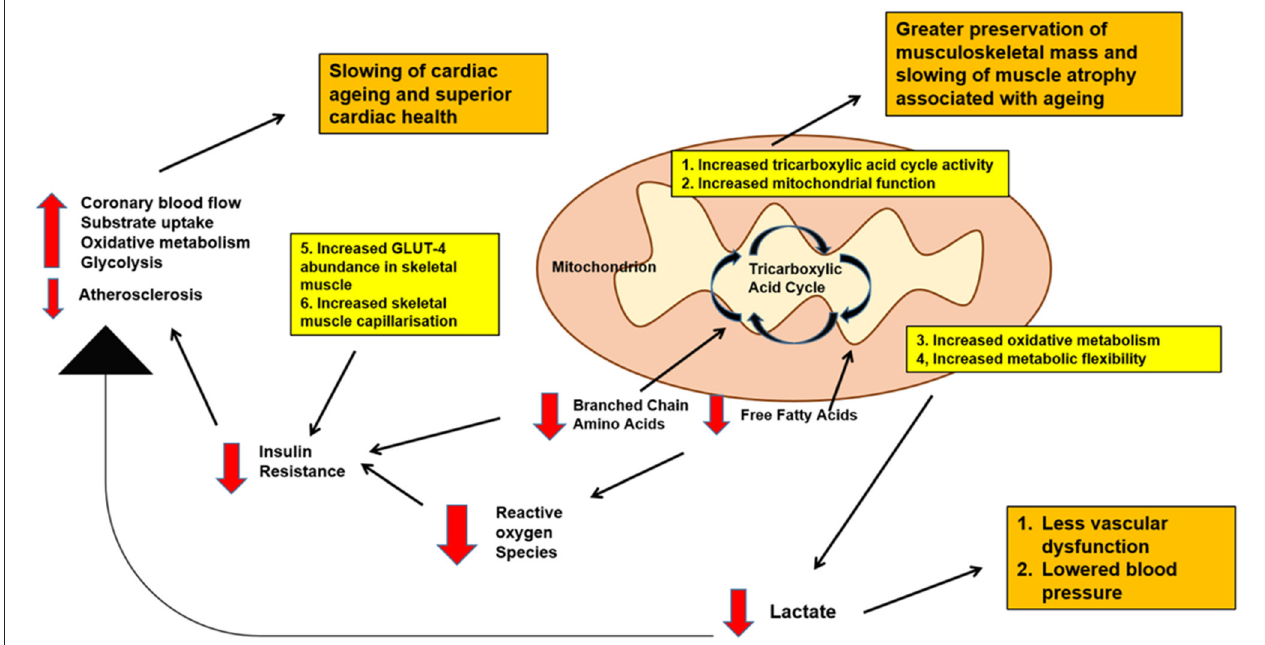
FIGURE 1 | Schematic diagram of possible metabolic pathways linking physical activity, cardiovascular health and musculoskeletal function with aging. Decreased levels of branched chain amino acids and free fatty acids, decreased baseline lactate, decreased blood glucose levels as well as increased musculoskeletal mass may be expected with physical activity. All these effects are important in promoting better cardiovascular health, slowing down cardiac aging as well as maintaining good musculoskeletal mass into old